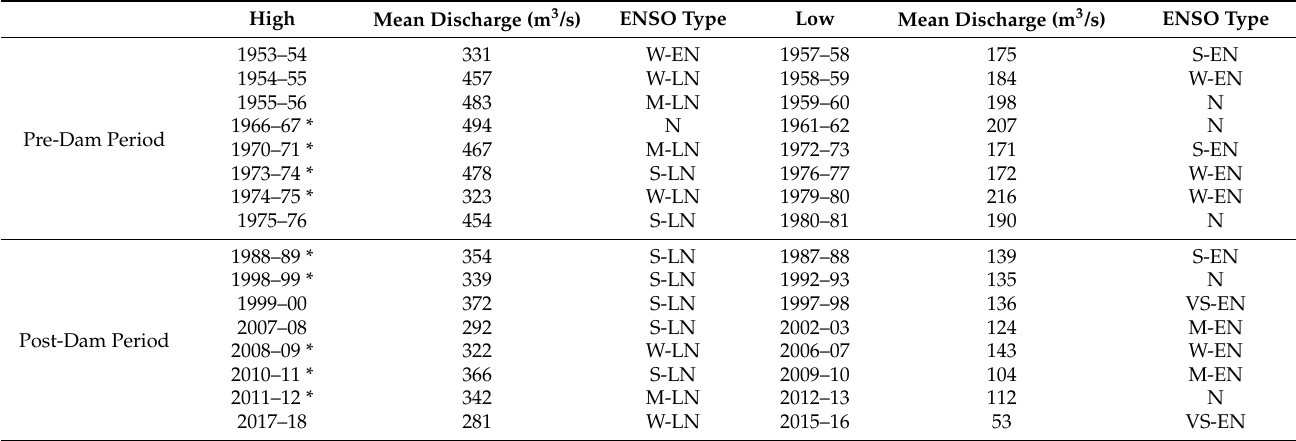
Table 1. Intense flow events pre- and post-Salvajina Dam. LN is for La Niña events and EN for El Niño (ENSO) events. According to the ONI Index, available at https://origin.cpc.ncep.noaa.gov/products/analysis_monitoring/ensostuff/ONI_ v5.php (accessed on 27 October 2021), W is for weak events, M for moderate, S for strong and vs. for very strong. N relates to neutral